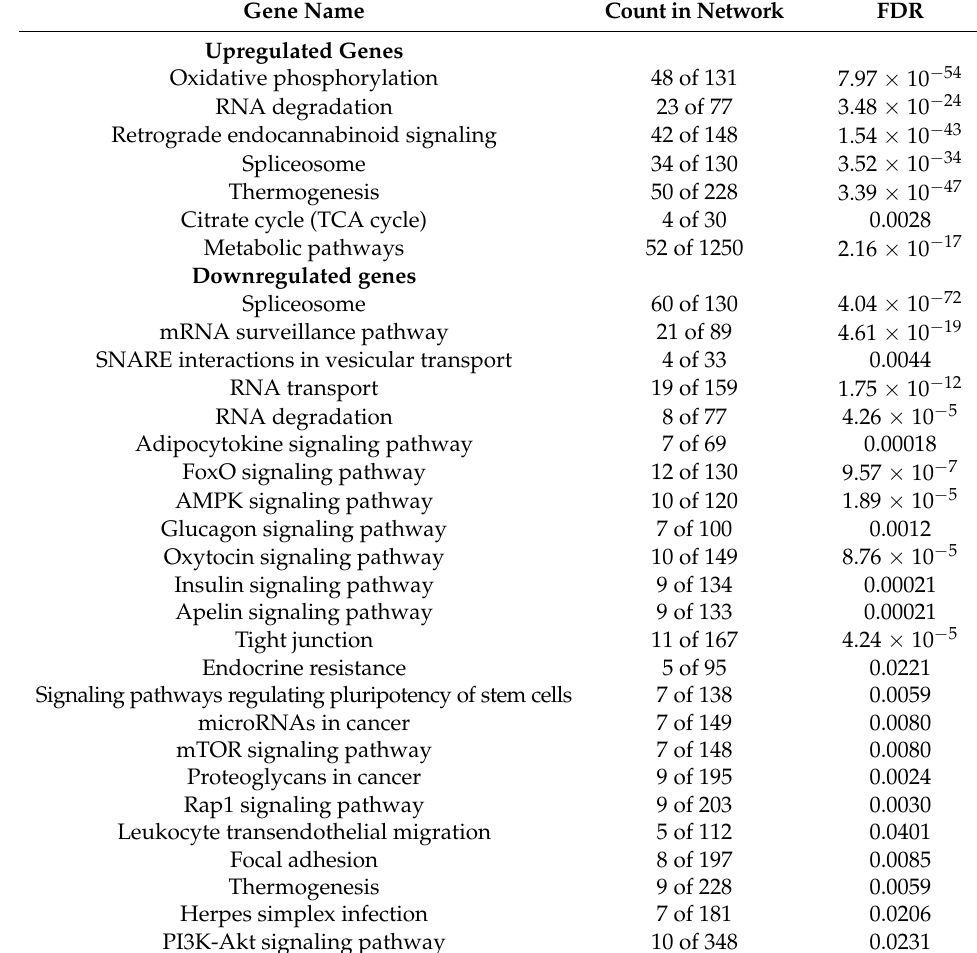
Table 1. KEEG pathway analysis of PPI network. Visualization of top dysregulated pathways by up- and downregulated DEGs in resistant patients samples from GSE62080 database using KEGG PATHWAY database (https://www.kegg.jp/kegg/pathway.html (accessed on 18 May